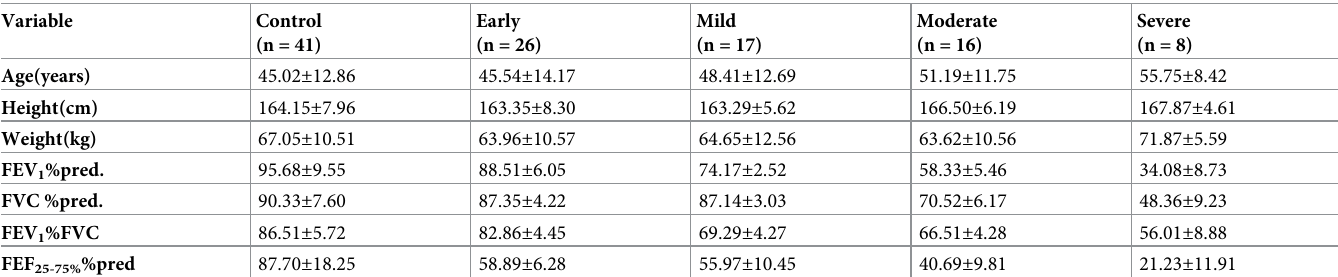
Data are expressed as mean ± SD. FEV1, forced expiratory volume in 1 second; FVC, forced vital capacity; FEF 25-75% , forced expiratory flow at 25 and 75% of the pulmonary volume; %pred. =